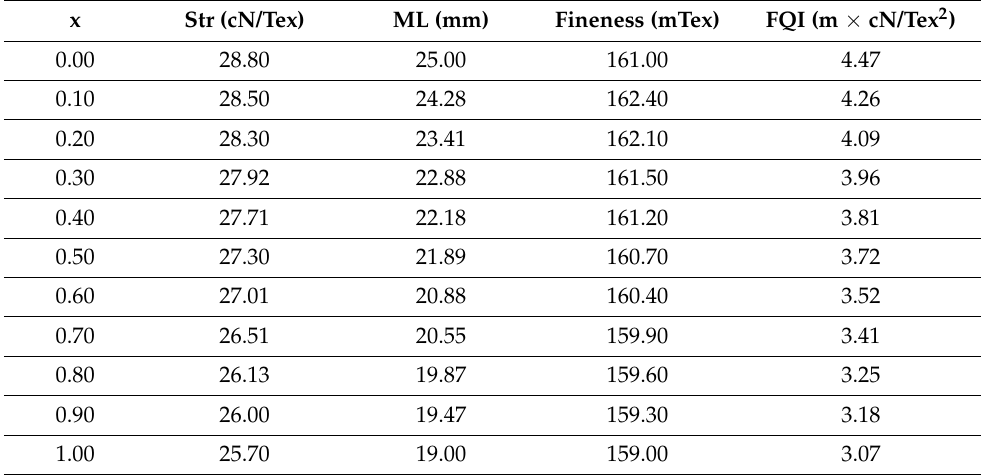
Table 5. FQI for the V2 and W2